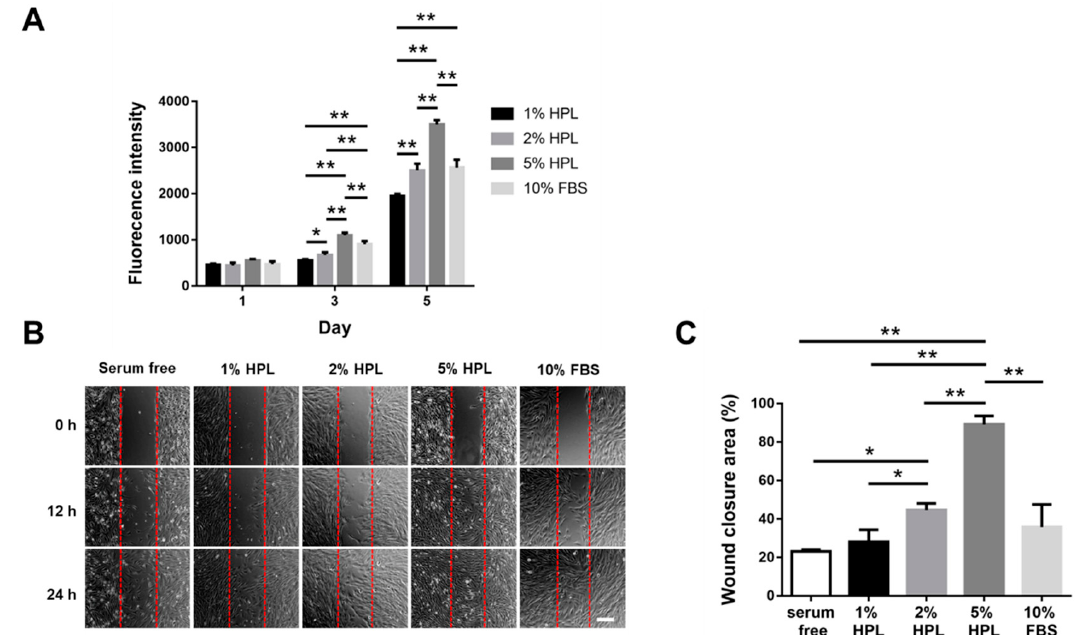
Figure 1. The influence of different concentrations of HPL on the proliferation and migration of Hs68 fibroblasts. ( A ) Alamar Blue assay revealed the proliferative activity of Hs68 fibroblasts incubated in different concentrations of HPL or 10% FBS. ( B ) The representative images of in vitro cell migration at 0, 12 and 24 h (scale bar = 200 µ m). ( C ) Quantification of the wound closure percentage of Hs68 fibroblasts at 12 h. Serum-free was used as the control group. (* p < 0.05, ** p < 0.01).